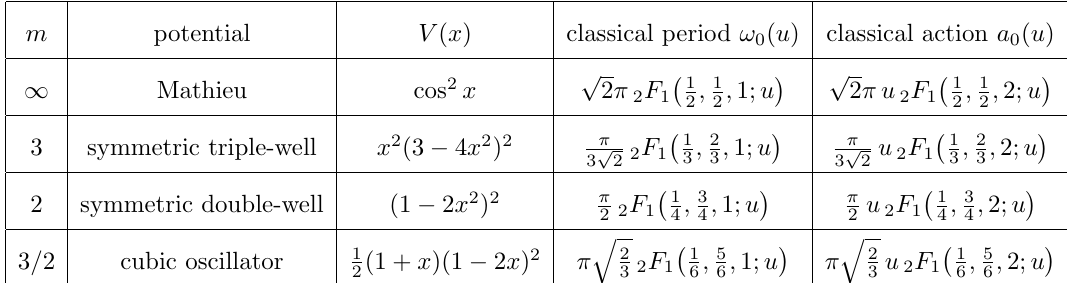
Table 1 . The classical periods and actions for a special class of Chebyshev potentials, which